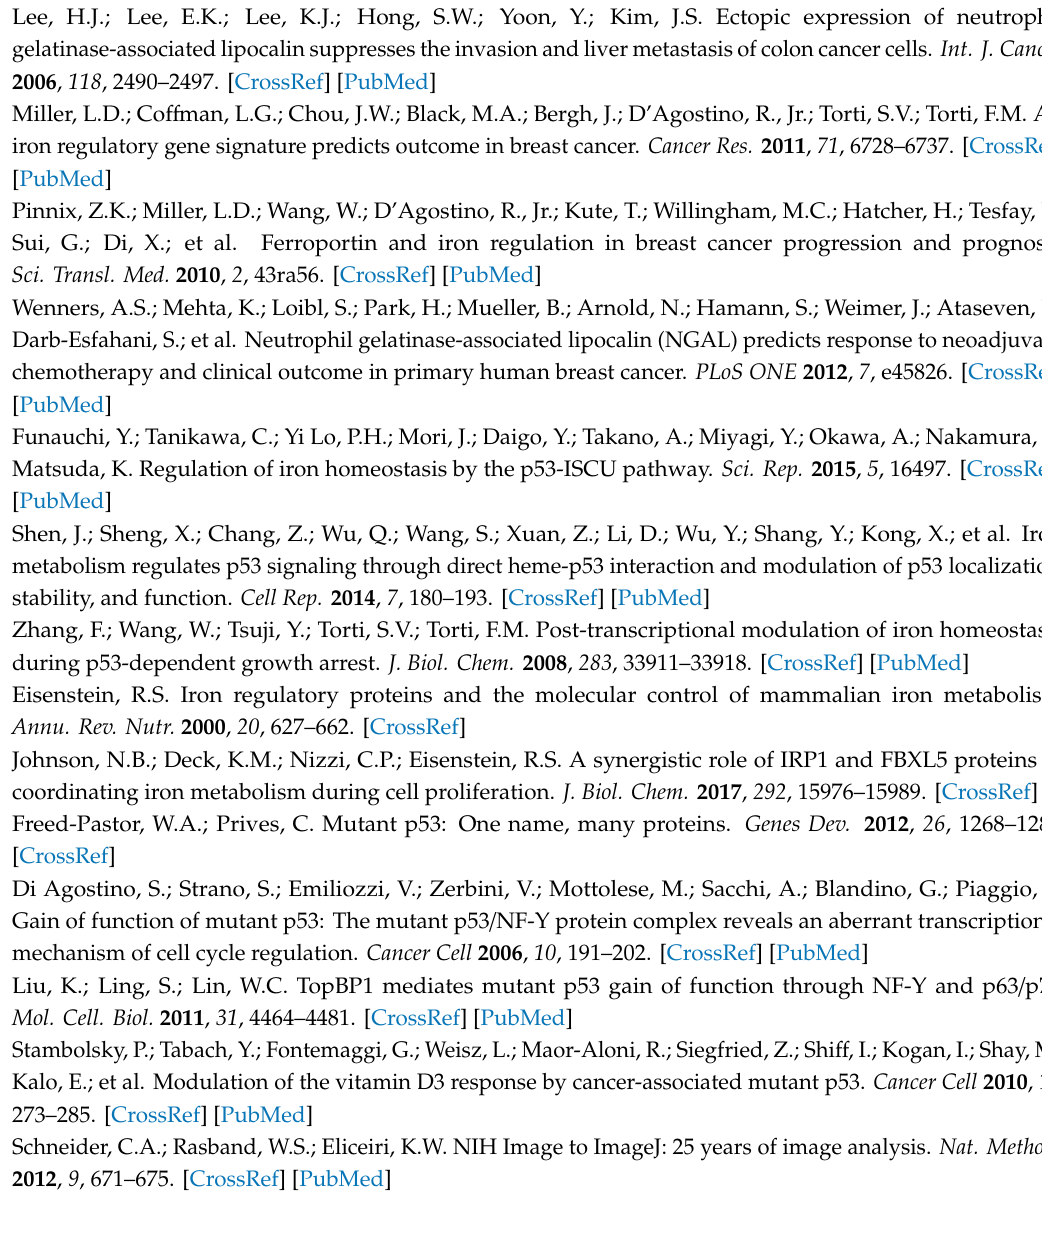
Table S1: Proteomics analysis of H1299 cells following induction of WT or R175H mutant